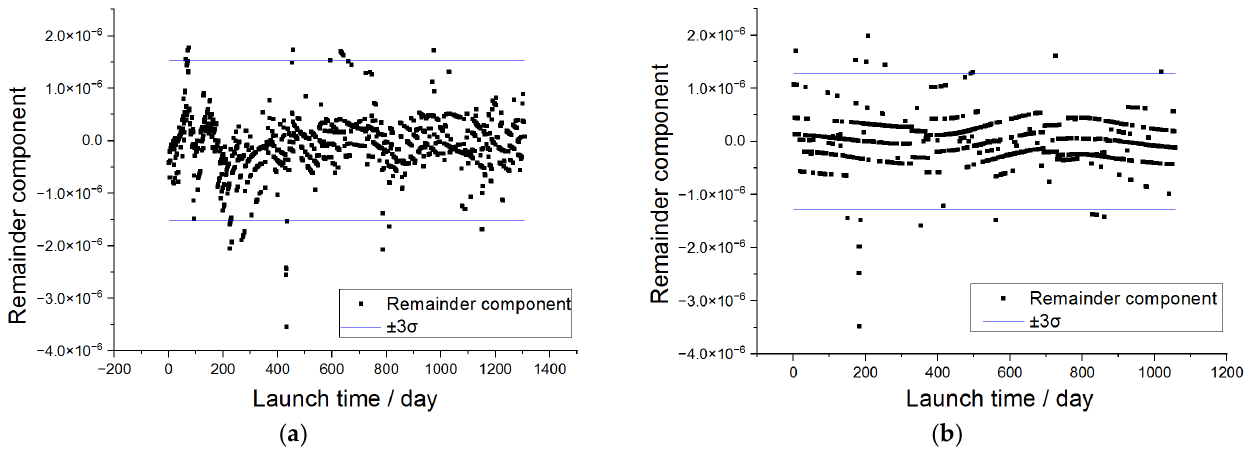
Figure 11. Remainder components and 3 σ criterion line to determine outliers. ( a ) Shows the re- mainder component and its corresponding 3 σ criterion lines using the entire calibration coefficients and (b) shows the remainder component and its corresponding 3 σ criterion lines using the calibra- tion coefficients data without the first 250 days.